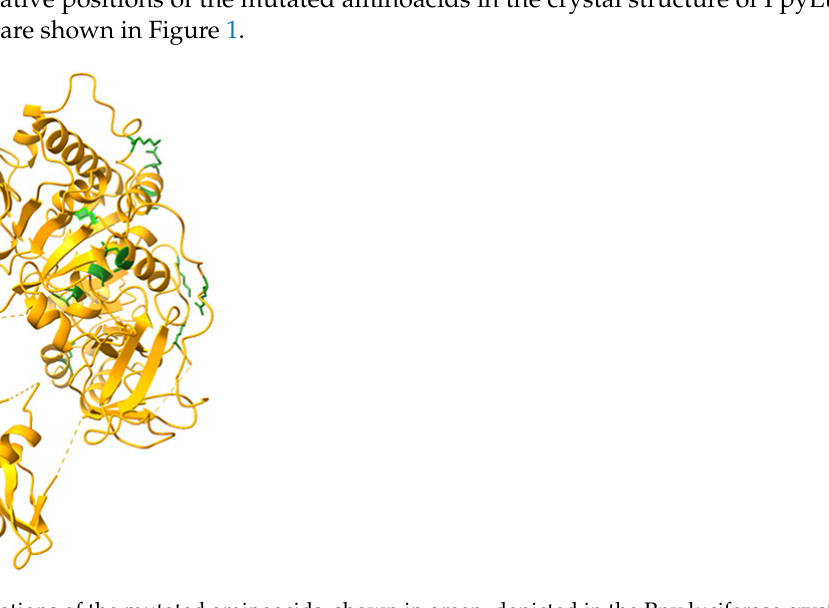
Figure 1. Locations of the mutated aminoacids, shown in green, depicted in the Ppy luciferase crystal structure (Protein Data Bank:1LCI). Modelling was performed with UCSF ChimeraX.